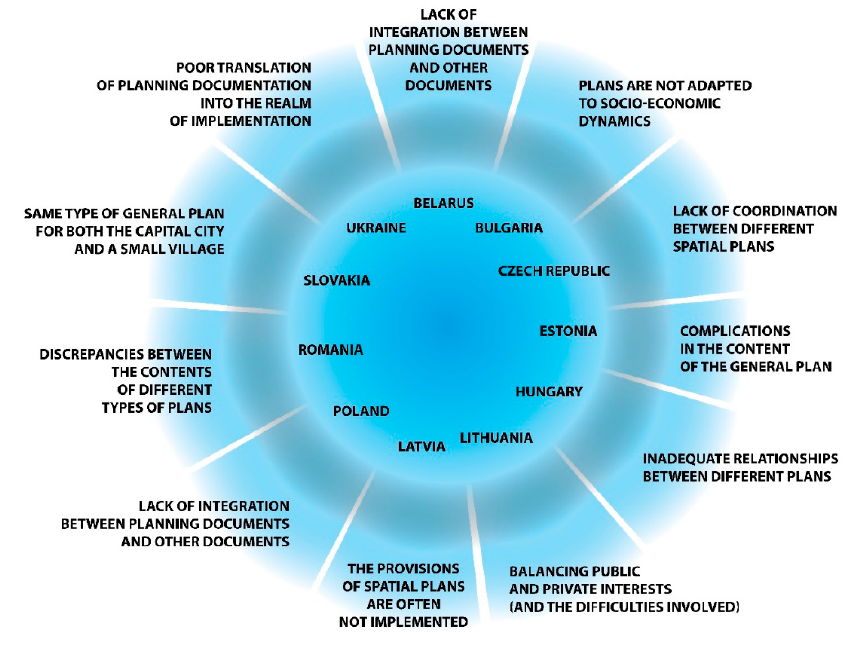
Figure 4. Legal problems concerning spatial plans in the countries surveyed. Table 2. Planning autonomy of local authorities and the legal dimension of spatial plans at the local level.